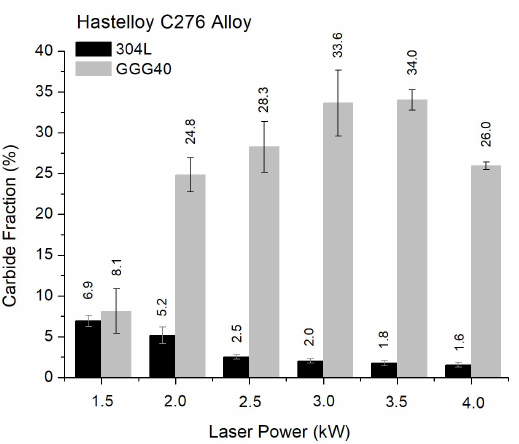
Figure 12. Carbide phase fraction for different